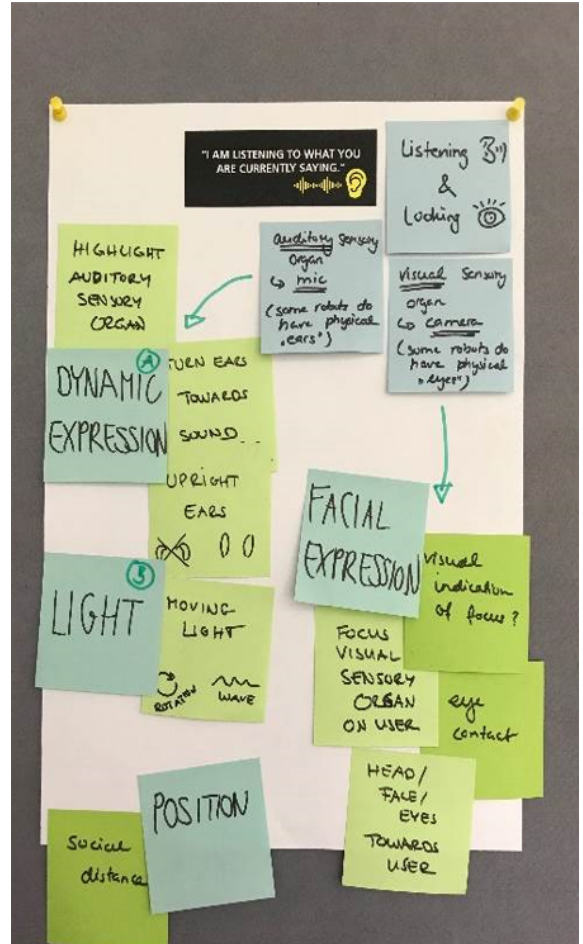
Figure 4. Idea clusters produced by the ideation workshop for the robot action “listen to